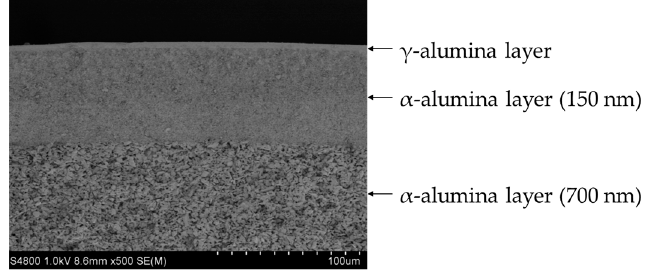
Figure 2. The SEM image of γ -alumina layer on the asymmetric substrate.